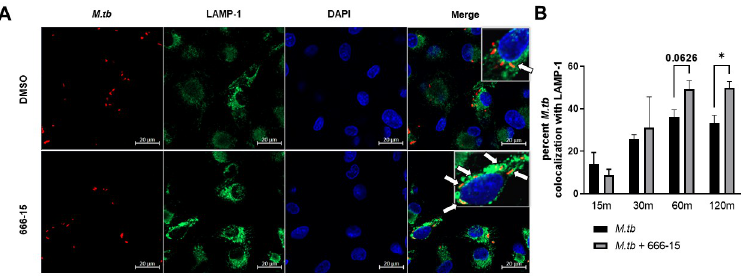
tb H 37 R v (red) MOI 10. MDMs were fixed, permeabilized, and stained for LAMP-1 (green) and DAPI (blue). A representative experiment is shown of n = 3 donors. B) At the indicated time points, the percent of M . tb colocalizing with LAMP-1 was calculated following manual counting. White arrows indicate colocalization. Data are cumulative ± SEM of n = 3 donors. Unpaired t test; * p <